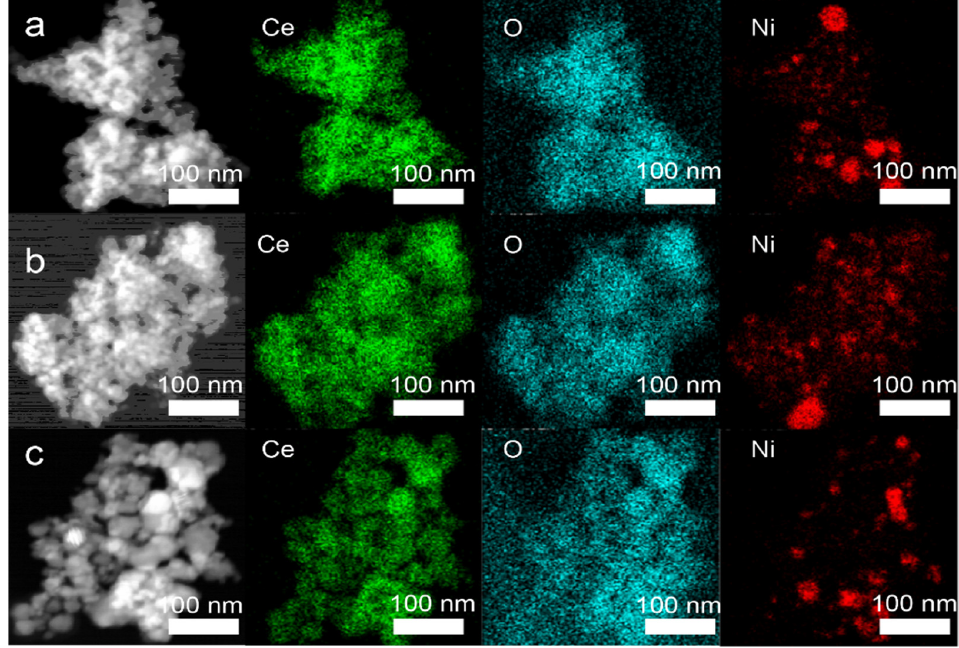
Figure 5. Typical high-resolution TEM (left column) and EDS mapping images of three catalysts: ( a ) Ni/CeO 2 (R), ( b ) Ni/CeO 2 (P), and ( c ) Ni/CeO 2 (C).